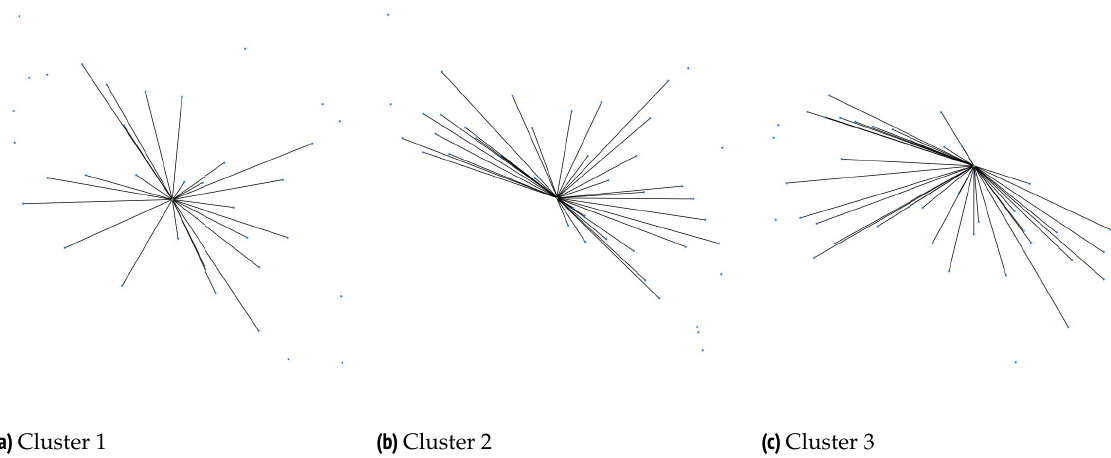
Figure 5: Using precise village locations to construct clusters. Notes: We illustrate the village clustering process above. Using locations of each sampled village and the sampled subset of the sampling frame (of villages), we construct